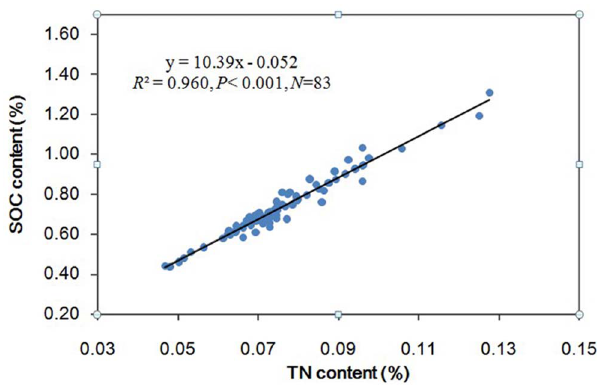
Figure 2. Relationship of topsoil soil organic carbon and total nitrogen content.